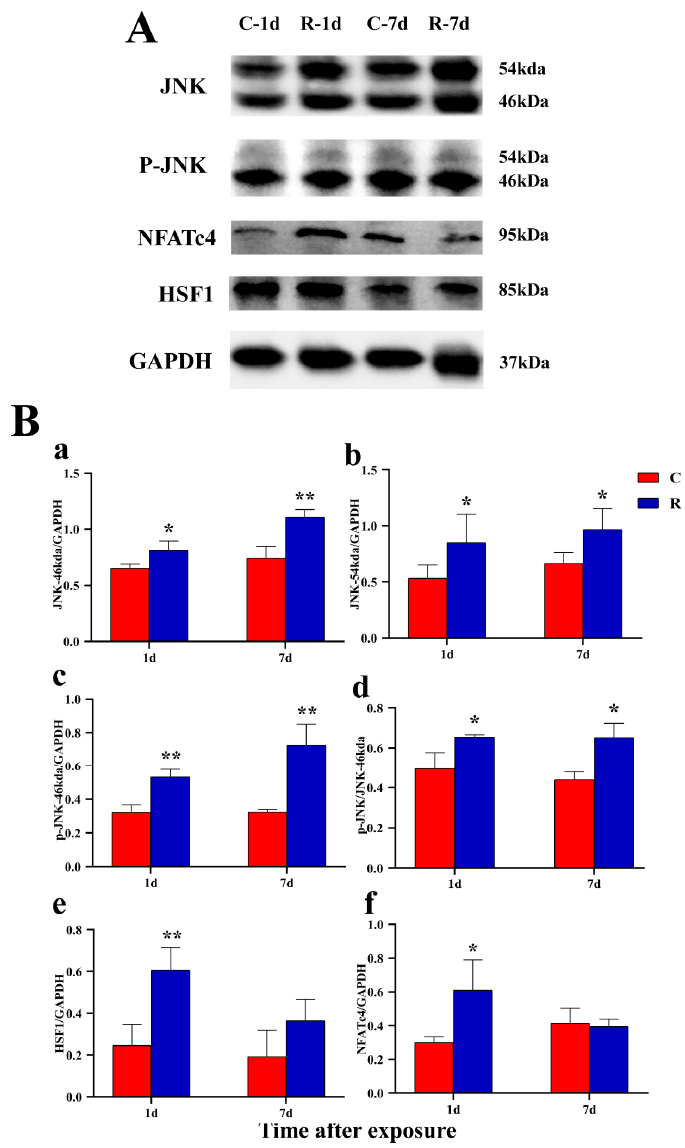
Figure 13. Changes in expression in rats’ myocardium after S-band radiation. ( A ) The original graphs of strips; ( B ) the graphs of statistical analysis:( a ) JNK-46 kDa; ( b ) JNK-54 kDa; ( c ) p-JNK-46 kDa; ( d ) p-JNK/JNK; ( e ) HSF1; ( f ) NFATc4. Signi fi cance signs were classi fi ed according to p -value: * p < 0.05 and ** p < 0.01.